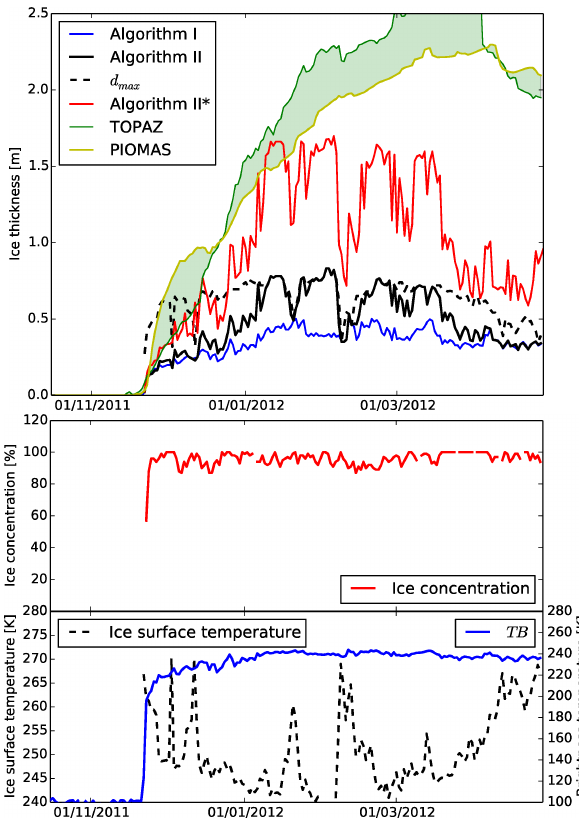
Figure 12. Time series of ice thicknesses derived from Algorithm I, II, and II*, together with d max and simulated ice thicknesses from TOPAZ and PIOMAS (upper panel) and time series of ice concen- tration (middle panel), snow (or ice in the case of bare ice) sur- face temperature and SMOS TB (lower panel) at Point 2 (71.0 ◦ N, 165.0 ◦ W).